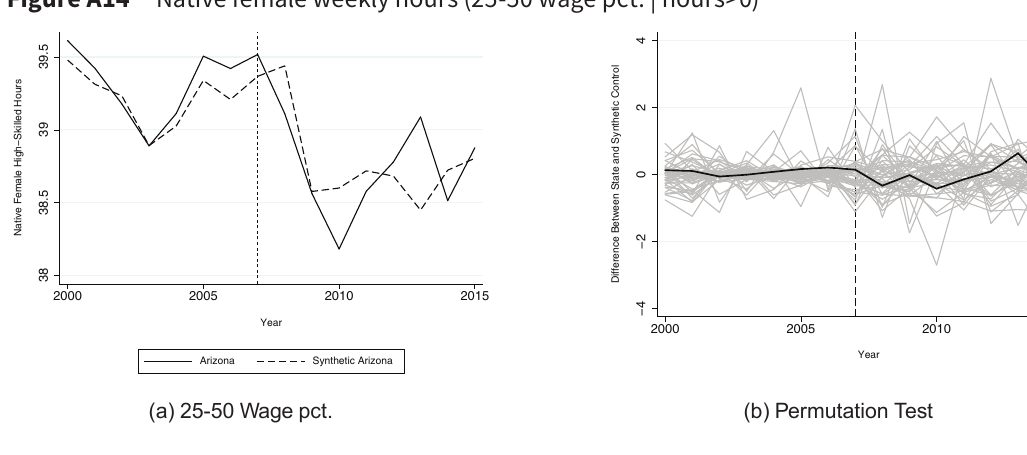
Native female weekly hours (25-50 wage pct. | hours>0)